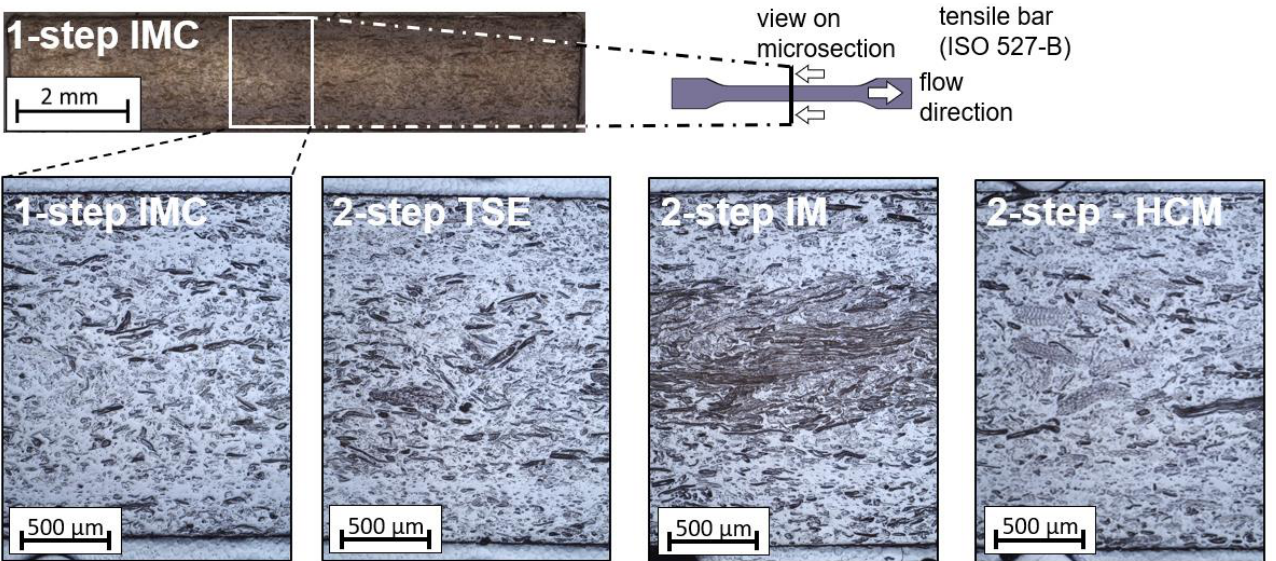
Figure 7. Microsection of the tested tensile rods in flow direction; position of the micrographs similar to those shown for one-step IMC; non-homogeneity and fiber bundles of the two-step IM process.